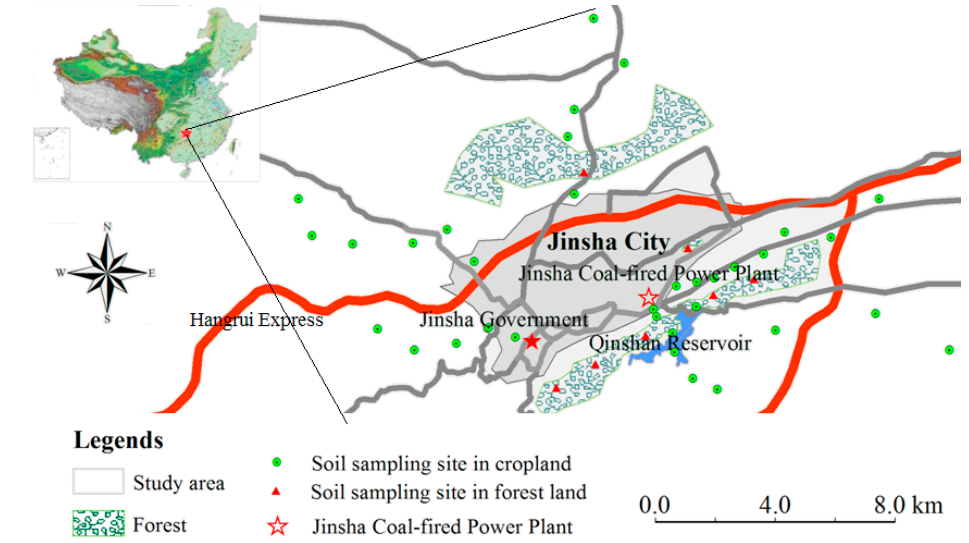
Figure 1. Distribution of sampling sites in the study region.